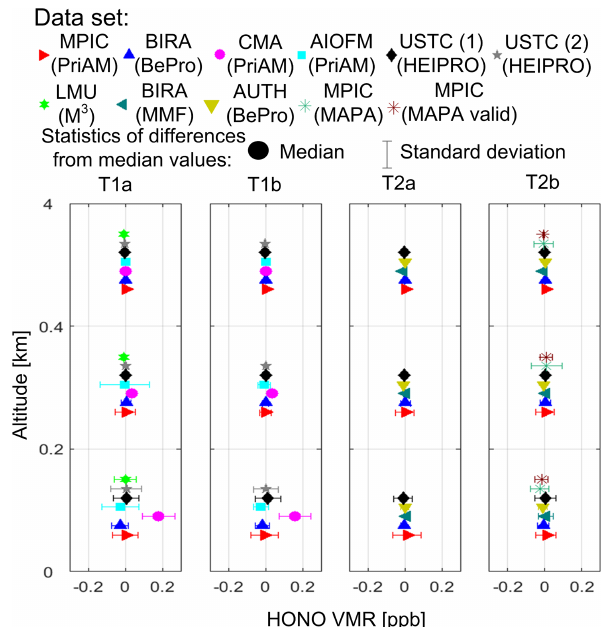
Figure 8. Median and standard deviations of the differences of the HONO VMR profiles derived from the individual participants com- pared to median values of all MAX-DOAS data for the whole cam- paign. The results in the vertical grids of 0 to 0.2km, 0.2 to 0.4km, and 0.4 to 4km are shown as three vertical clusters of dots in the figures. Different subfigures represent results for different